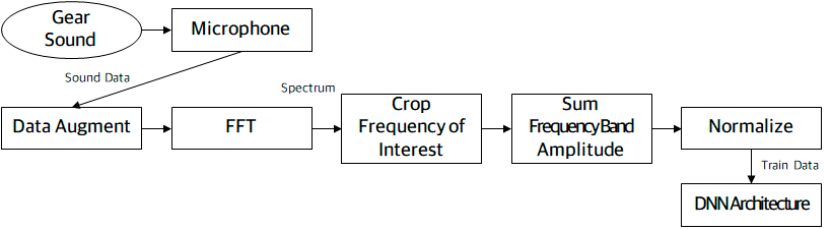
Figure 3. Flow chart of sound spectrum analysis for classifier model training.